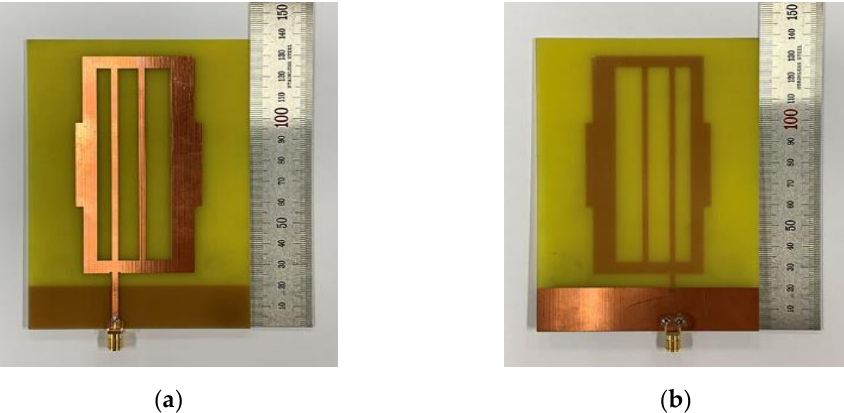
Figure 10. The prototype of the proposed UHF antenna: ( a ) top view and ( b ) bottom view.